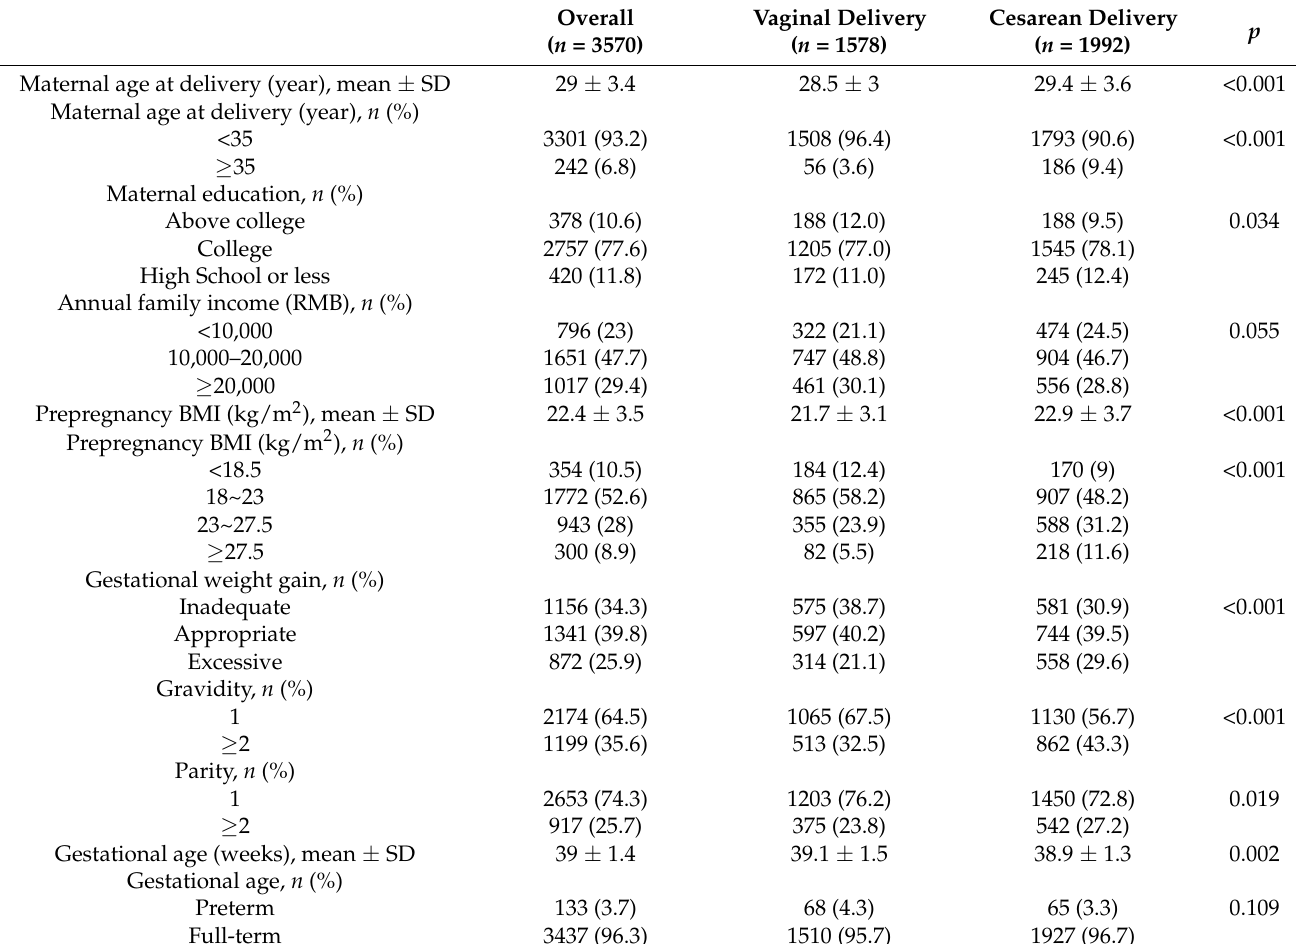
Table 1. Maternal and child characteristics according to delivery mode a . Overall ( n =